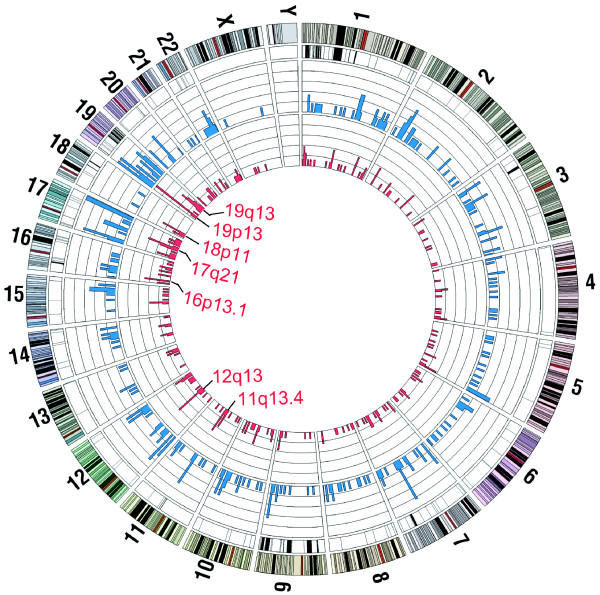
Somatic mutations in glioma cells. From the outsider, Tracks 1 and 2: numbering and cytobands of different chromosomes. Track 3: black bars showing the LOH-enriched loci in chromosomal regions, most prominently in 1p, 9p, 9q and 19q. Track 4: blue bars showing number of somatic indels of ≤ 30 bp per 5-Mb window (scale: 0-6). Track 5: red bars showing number of somatic SNVs per 5-Mb window (scale: 0-8). The cytogenetic locations of seven potential SNV hotspots displaying a density of somatic SNVs > 4, viz. greater than the sum of the Mean (= 1.5) plus two-times the standard deviation (= 1.9), per 5-Mb window are indicated as 11q13.4, 12q13, 16p13.1 etc.